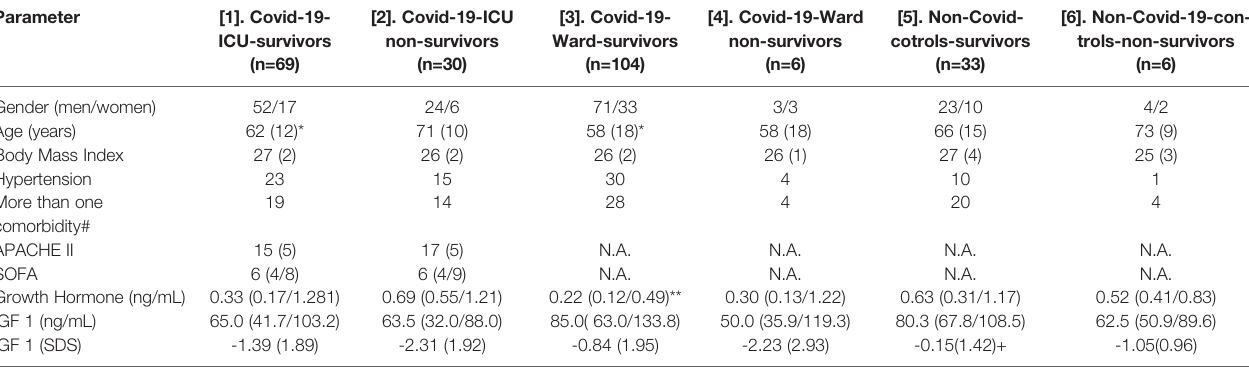
TABLE 1 | Demographics, clinical and laboratory data of the study ’ s patients; data are presented as means (standard deviation), median (25 th percentile/75 th percentile) or counts. Parameter